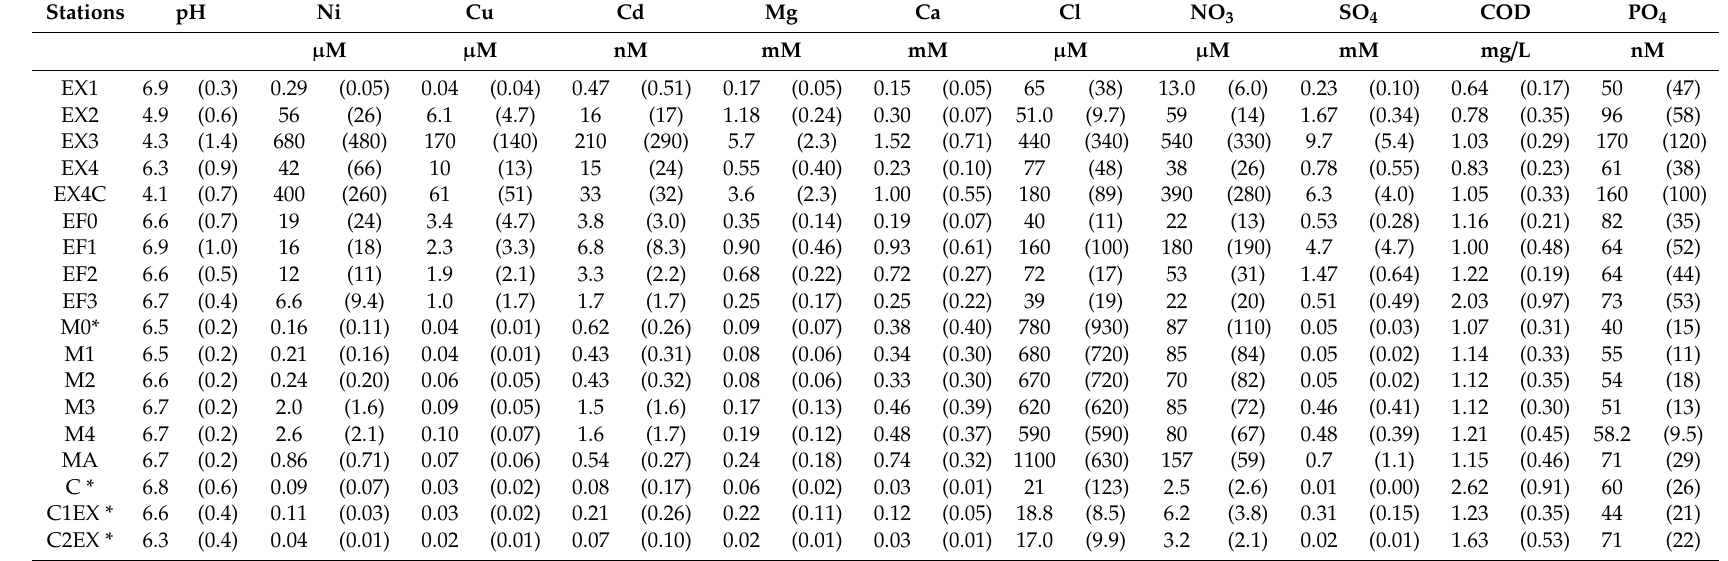
Table 1. Physico-chemical characteristics (mean and standard errors in brackets) for the 17 sampling